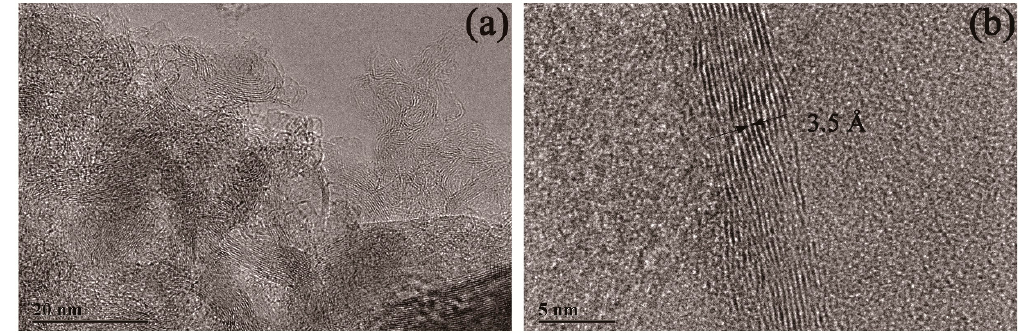
Figure 7. TEM images of multilayered graphene treated with a 2.0 M concentration of HCl. ( a ) Typical stripe structures that occurred on the surface of the sample. ( b ) A high-resolution TEM image of multilayered graphene.